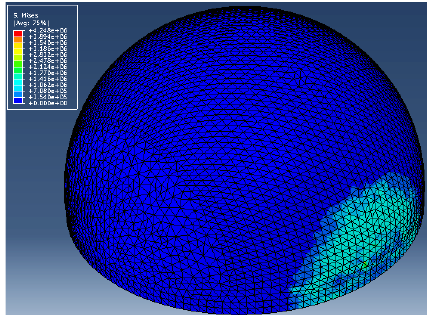
Fig. 18. Von misses composite stress contour in spherical